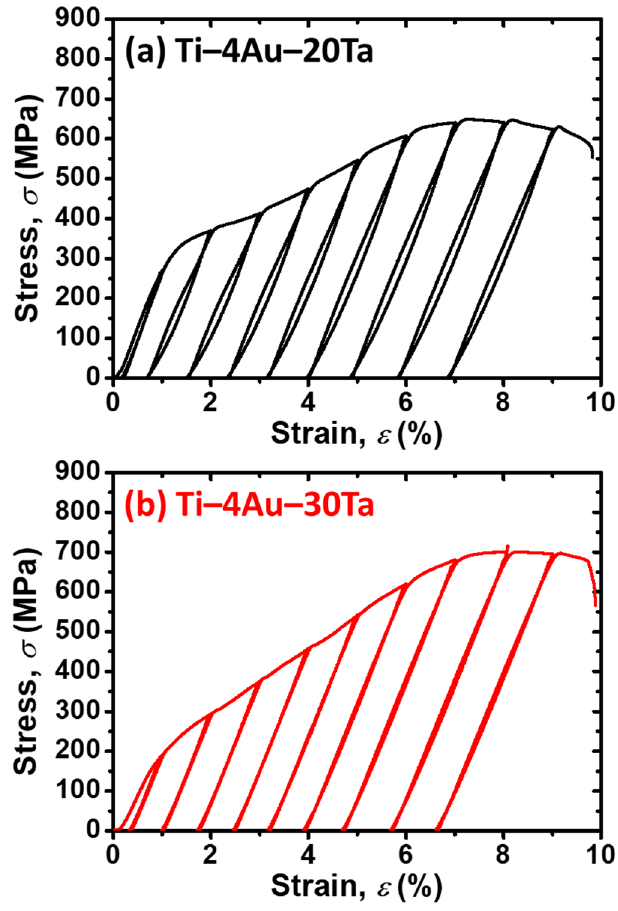
Figure 6. Cyclic loading–unloading tensile tests of the ( a ) Ti–4Au–20Ta alloy and the ( b ) Ti–4Au–30Ta alloy at RT under ambient.